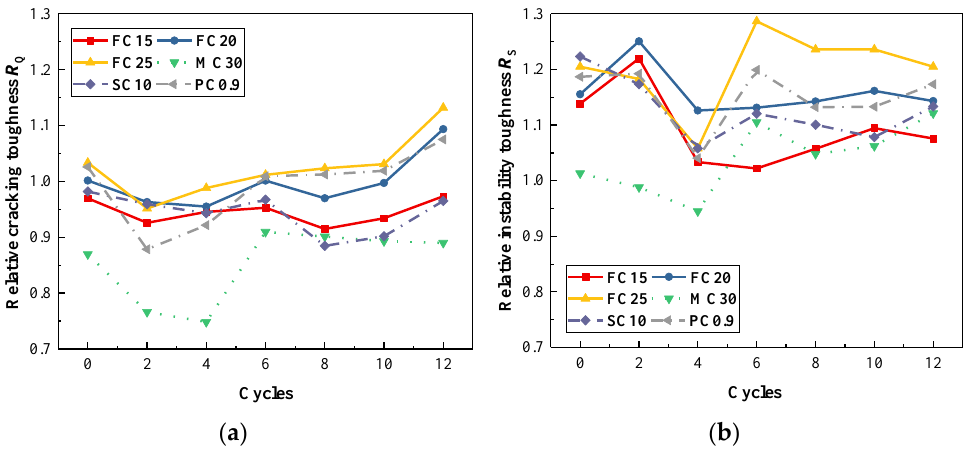
Figure 7. Evolution of relative fracture toughness. ( a ) Relative cracking toughness, ( b ) relative instability toughness.